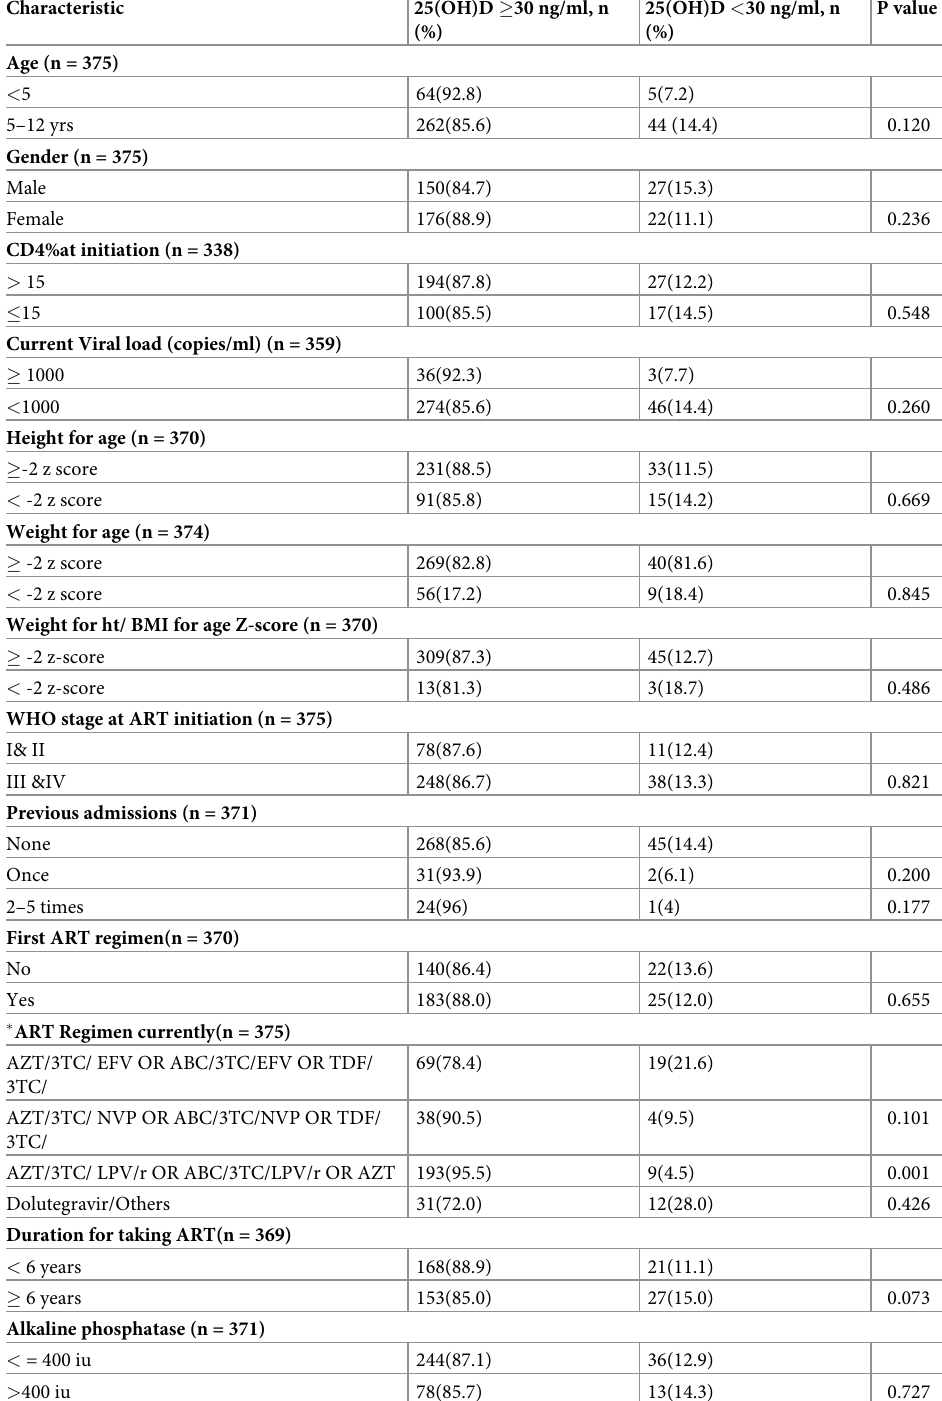
Table 1. Sociodemographics and clinical